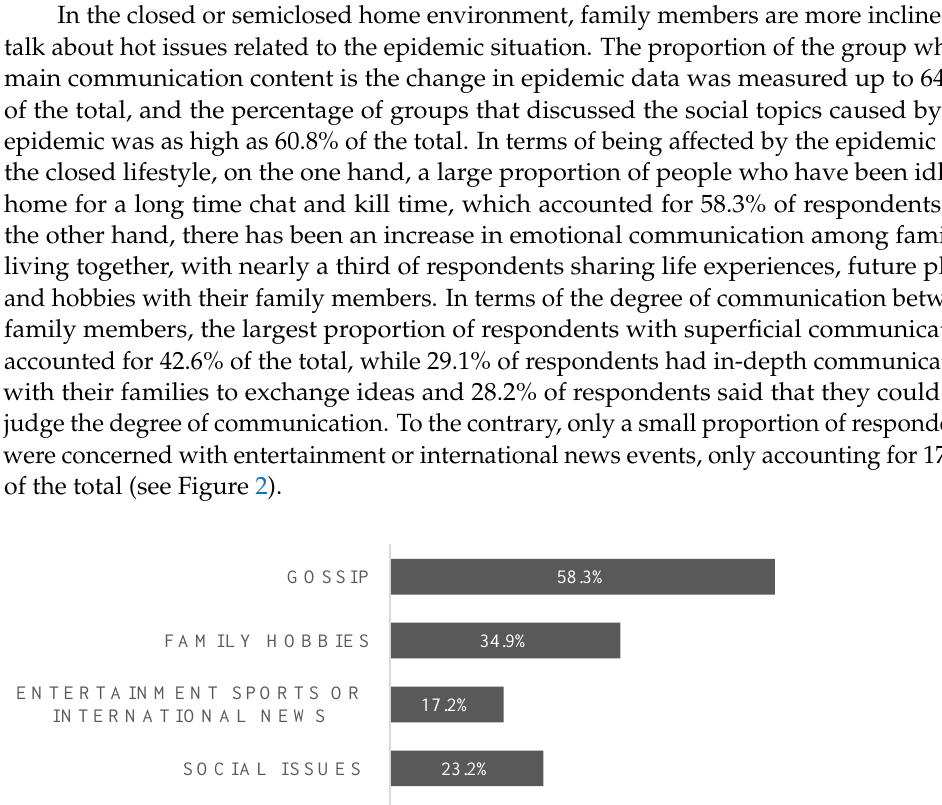
Figure 1. Changes in interaction between the interviewees and their family member under the epidemic.